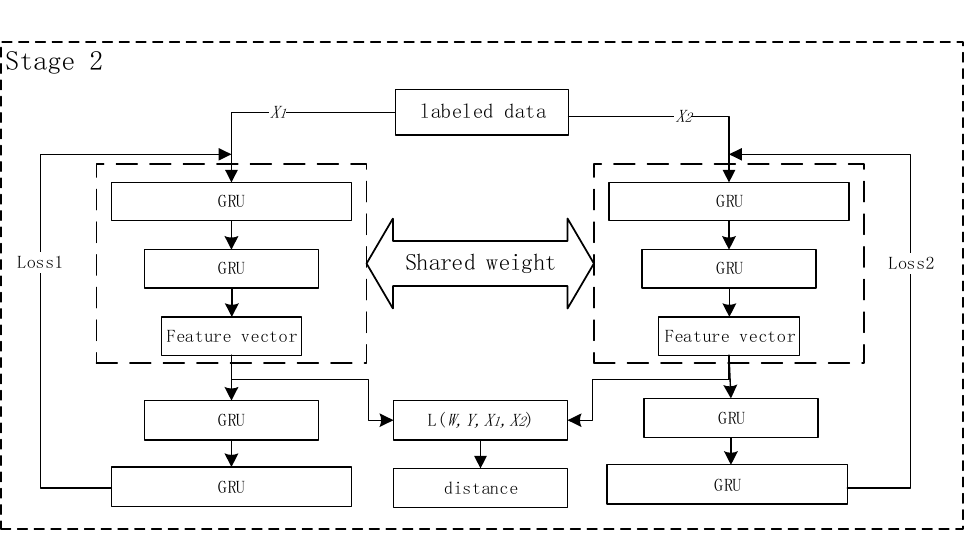
Figure 6. The model of stage two.